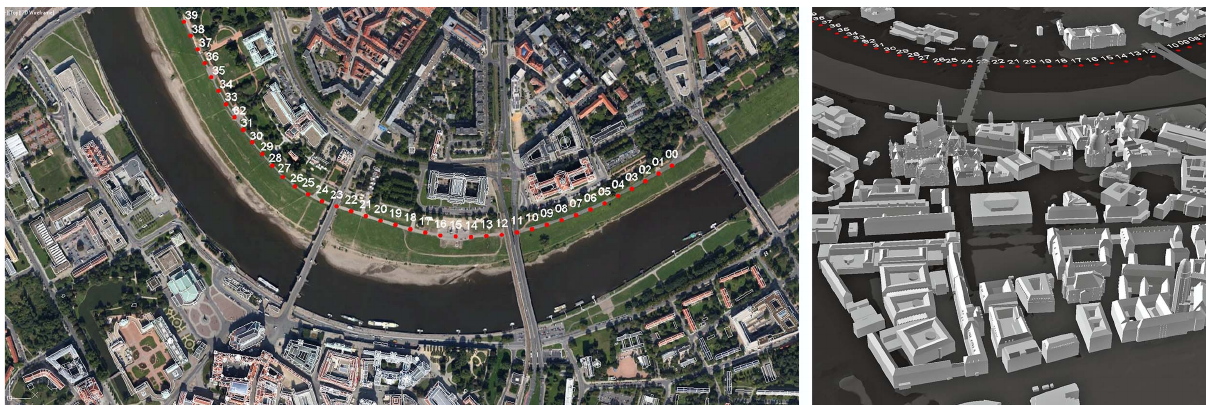
Figure 7. Distribution of observation points covered by VPS method